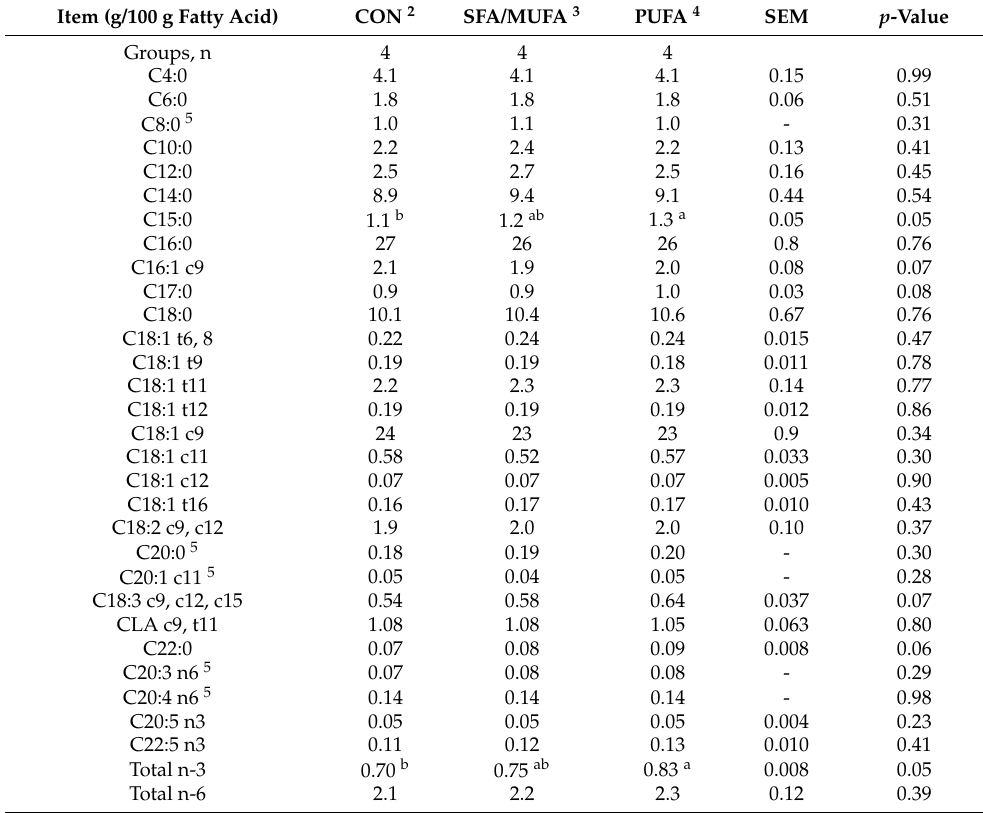
Table 8. Effects of supplementation for the last 82 ± 5 d of gestation of soybean hulls mixed with either whole-shelled corn (CON), Ca salts of saturated/monounsaturated fatty acids (SFA/MUFA), or Ca salts of polyunsaturated fatty acids (PUFA) on milk fatty acid profile 1 .